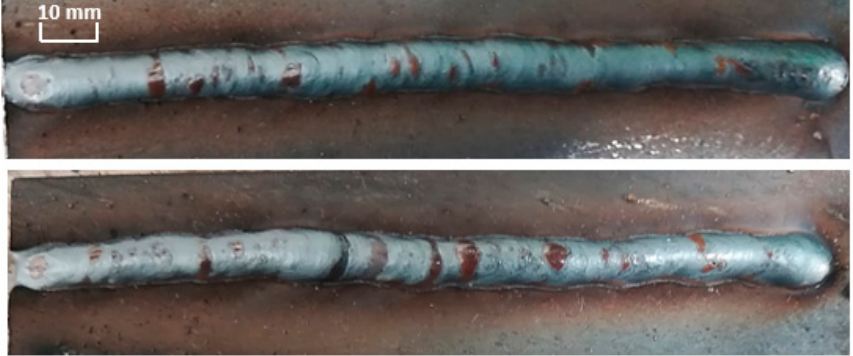
Figure 9. Results of the MR-integrated visual/haptic tele-welding system from a professional welder